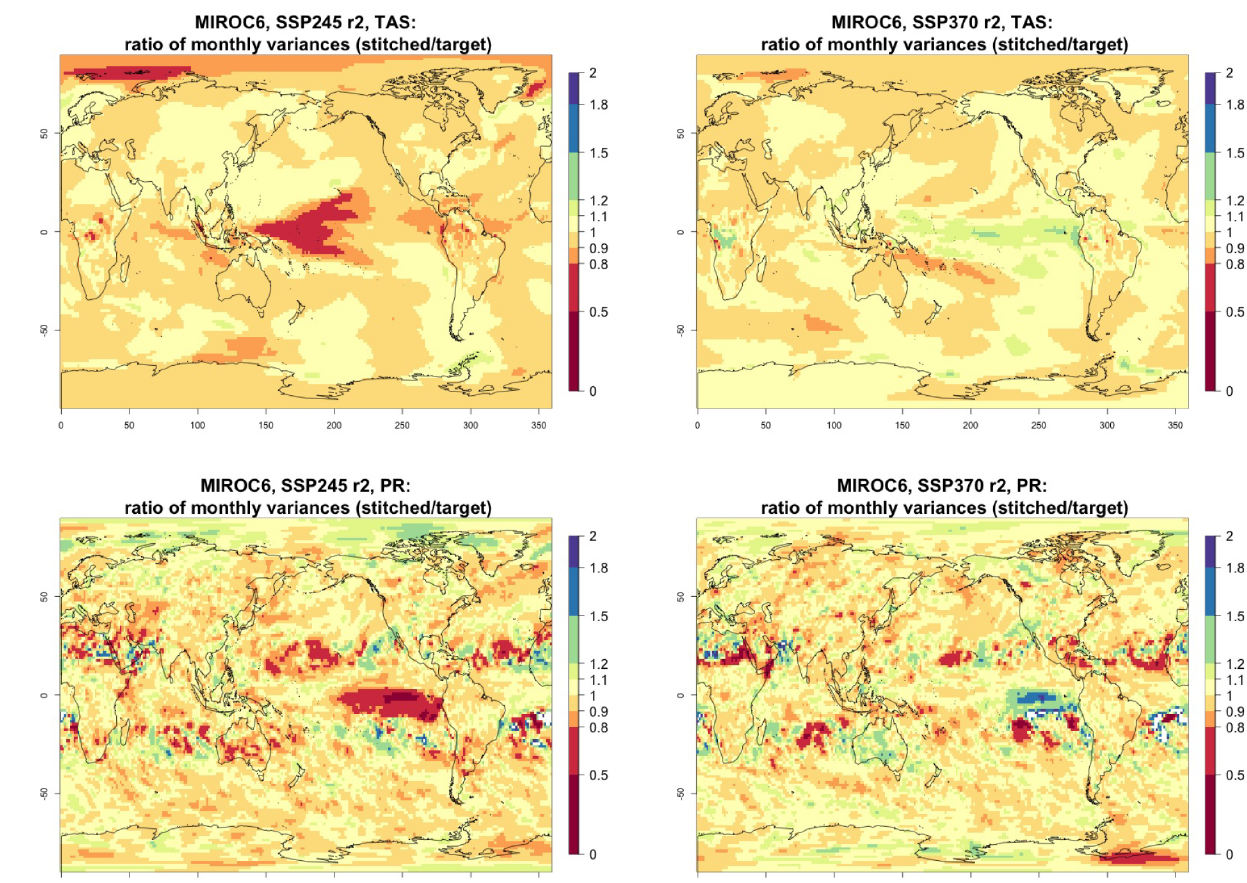
Figure C9. Ratio of monthly variability (standard deviation of residuals from trends) in temperature (TAS) and precipitation (PR) between stitched (at the numerator) and target (at the denominator) time series. The value of the ratio is expressed by the color scale, which highlights the transitions at 0.8 and 1.2. Emulation of MIROC6, monthly time series over 2015–2100, for SSP2-4.5 and SSP3-7.0. Second realization.